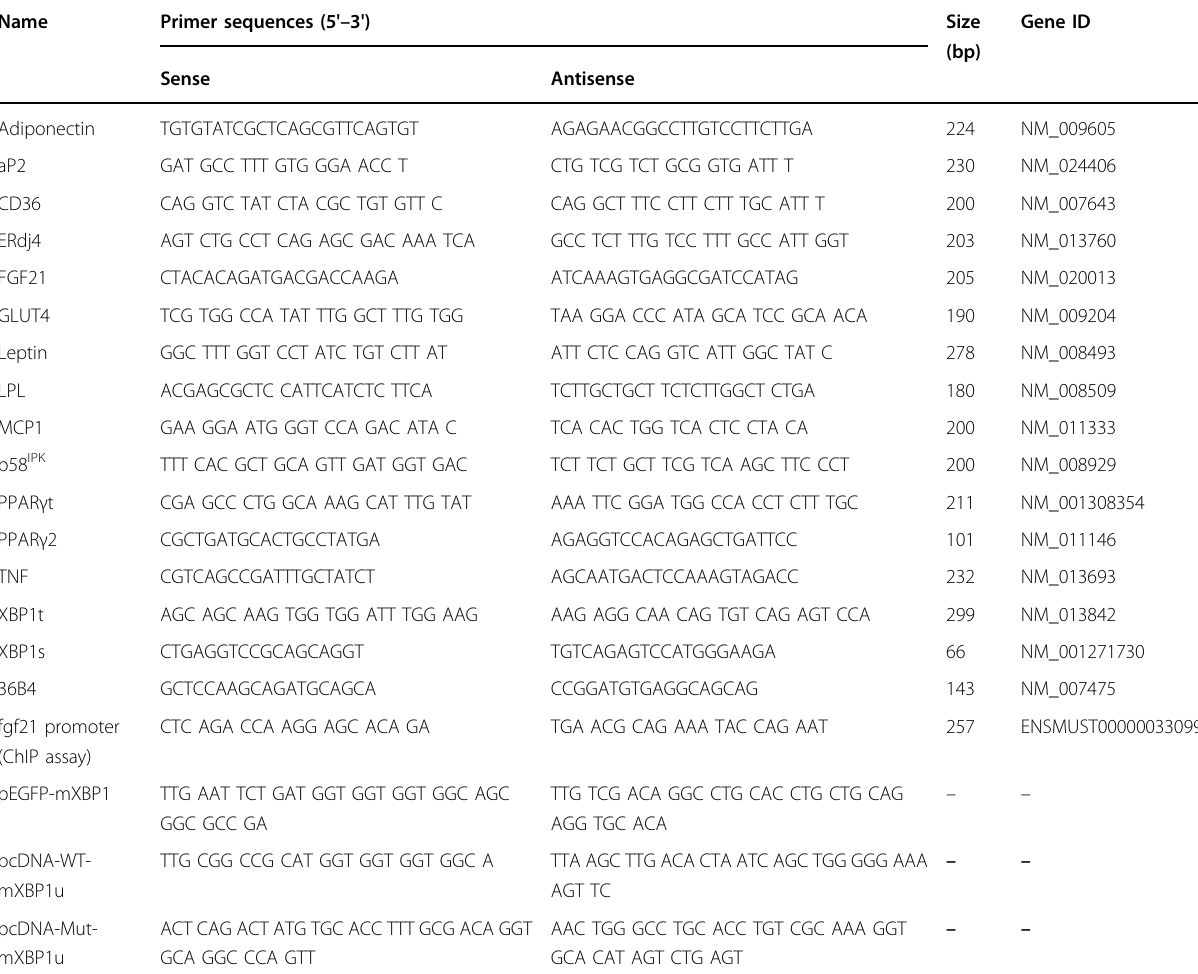
Table 1 Primer sequences for PCR